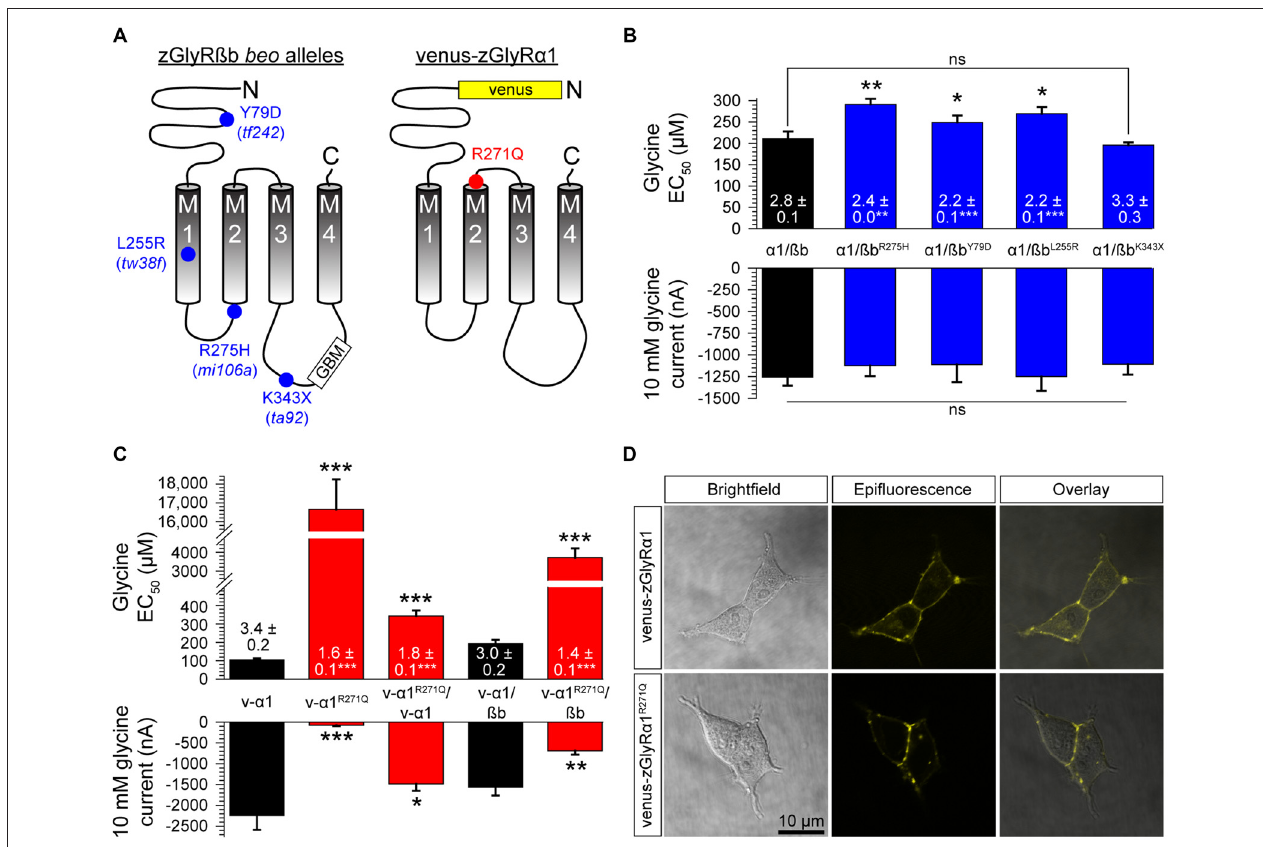
FIGURE 7 | Mutations in zGlyRßb and zGlyR α 1 result in hypomorphic receptors. (A) Location of mutations in zGlyRßb that give rise to bandoneon ( beo ) mutants, and analogous position in hGlyR α 1 of mutations that cause hyperekplexia. (GBM) Gephyrin-binding motif. (B) Cumulative effects of bandoneon mutations on heteromeric receptors’ EC 50 for glycine and average 10 mM glycine-evoked currents. Of note, oocytes were injected with 1 femtomole of zGlyR α 1 cRNA and four femtomoles of zGlyRßb cRNAs. Ten oocytes were used for each assay. Numbers inside bar here and in (C) represent Hill coefficient, and ∗ p < 0.05, ∗∗ p < 0.01, and ∗∗∗ p < 0.001. (C) Effect of dominant-negative R271Q mutation on both homomeric and heteromeric receptors’ EC 50 for glycine and average 10 mM glycine-evoked currents. Each oocyte was injected with 2.5 femtomoles of venus-tagged zGlyR α 1 cRNAs and 2.5 femtomoles of zGlyRßb cRNA. Ten oocytes were used for each assay. (D) Confocal images of HEK293T cells expressing venus-tagged zGlyR α 1